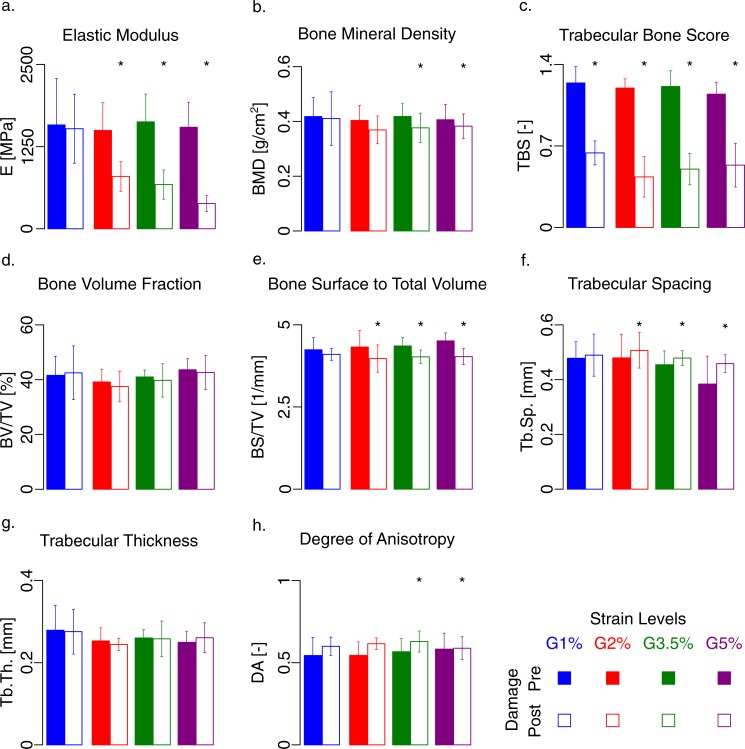
Variation of mechanical (E), clinical (BMD and TBS) and morphological parameters (BV/TV, BS/TV, Tb.Sp, Tb.Th, DA), -before and after damage—for each mechanical damage level (G1%, G2%, G3.5%, and G5%).The filled bars represent the results before damage and the unfilled ones after damage; the labels on the abscissa indicate the damage level. a) Elastic modulus significantly changes within the different group. b) BMD is not affected by the presence of damage. c) TBS significantly changes due to post-yield damage, although no significant difference has been observed between different post-yield damage levels. d) BV/TV does not change through damage loading. The variation of BS/TV (e) and Trabecular spacing (f) is nonzero for the three mechanical groups, G2%, G3.5%, and G5%. g) Trabecular thickness remained the same after applying the damage. h) The degree of anisotropy significantly changes for groups 3.5% and 5%. Asterisk sign shows the significant level (p < 0.0125) in the case of comparison, based on the ANCOVA tests.